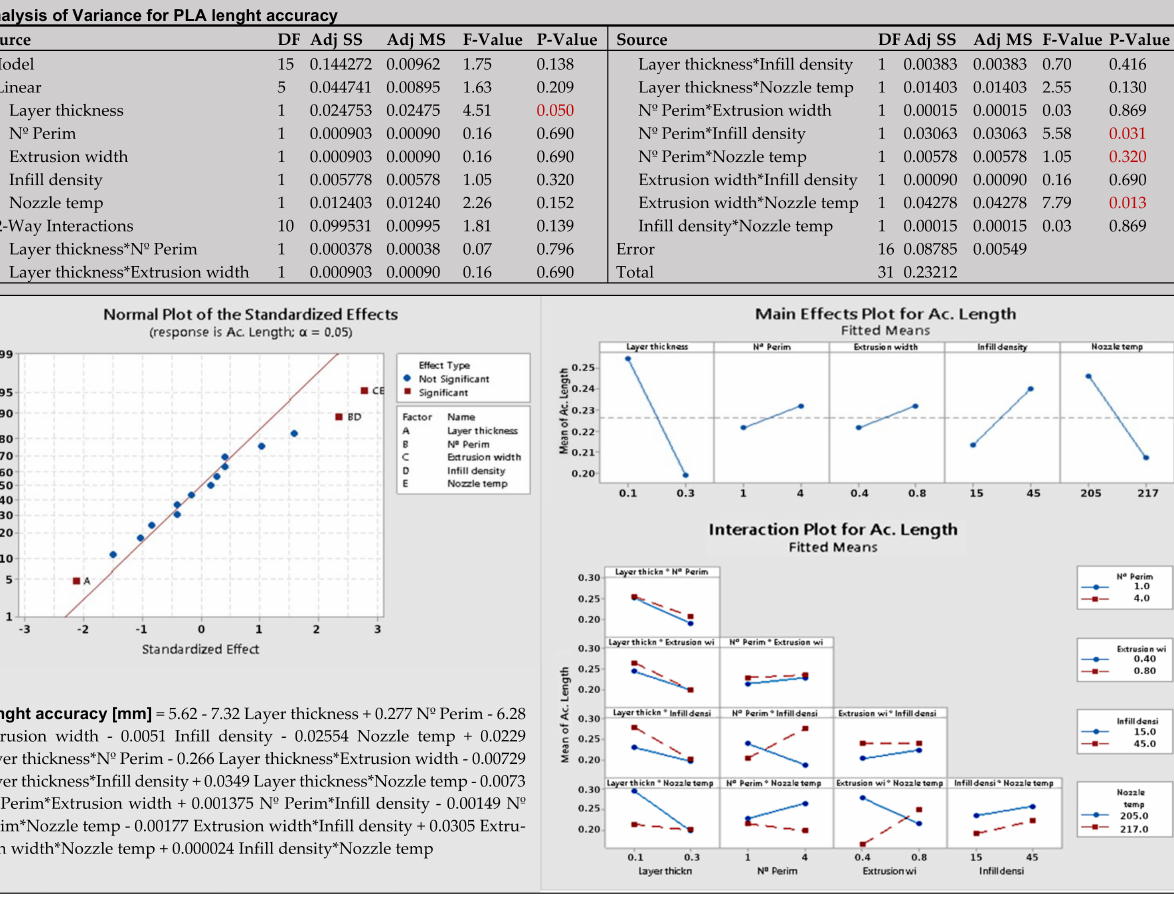
Figure 7. Graphical presentation of results for PLA accuracy of length. Table 3 summarizes the result of the analysis. It contains statistically significant factors and interactions where the p -value is less than 0.05. Table 4 lists measured dimensional accuracy of samples printed with various setups for all three materials. The table contains absolute deviations from the nominal dimensions of the sample. The lowest overall range (marked in green) was measured for PETG and the highest (red) for PHA material. Table 3. The significant factors and interactions for young modulus and length accuracy.